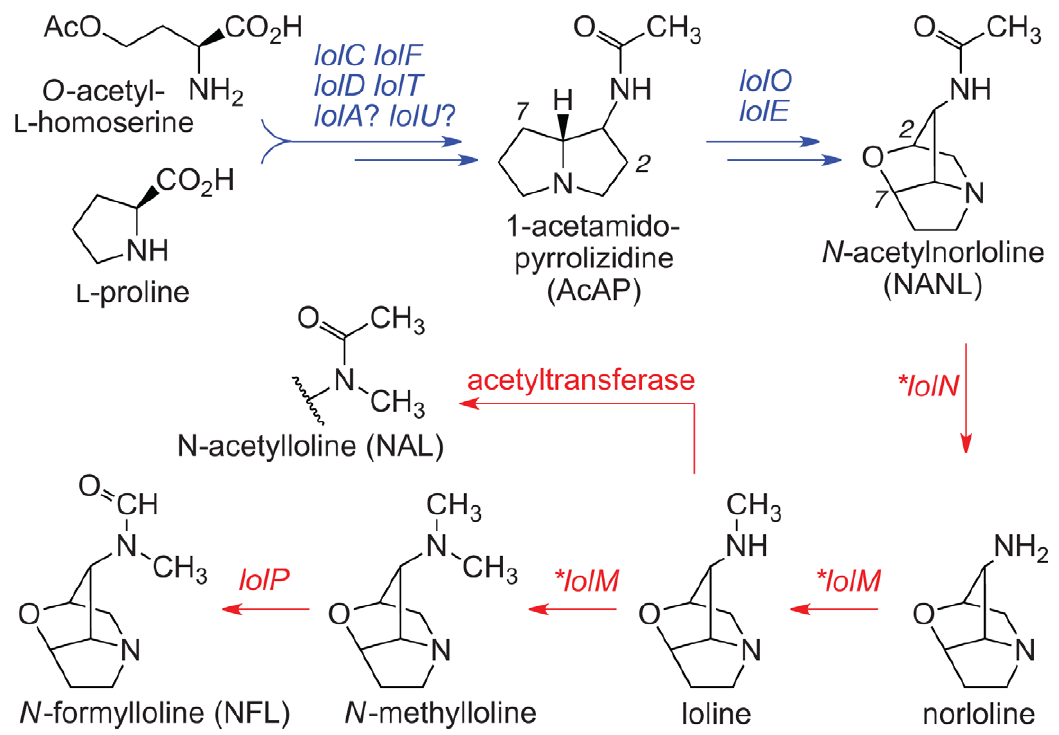
Figure 4. Summary of loline alkaloid-biosynthesis pathway. Arrows indicate one or more steps catalyzed by products of the genes indicated. Arrows and genes in blue indicate steps in synthesis of the first fully cyclized intermediate (NANL). Arrows and genes in red indicate steps in modification of NANL to give the variety of lolines found in the epichloae. Asterisks indicate LOL genes that were newly discovered in the genome sequence of E. festucae